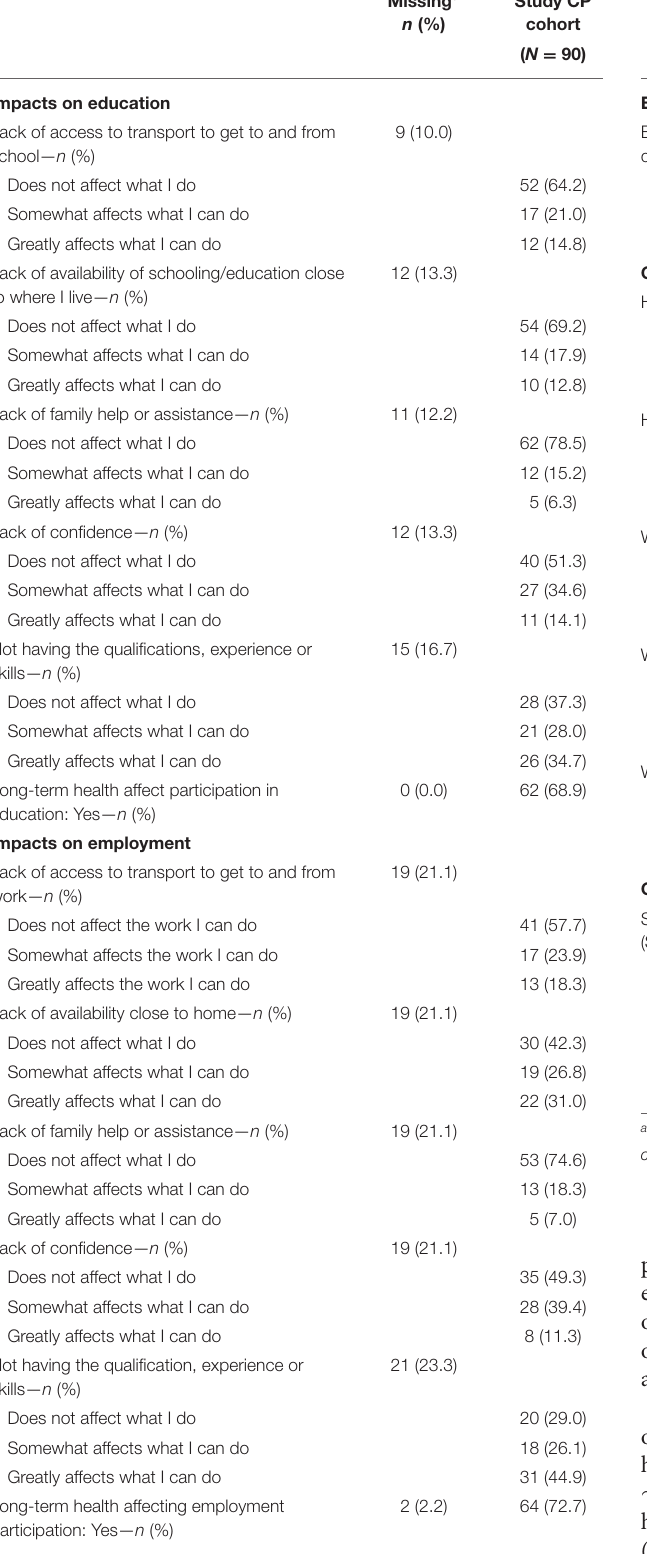
Missing a Study CP n (%) cohort ( N =